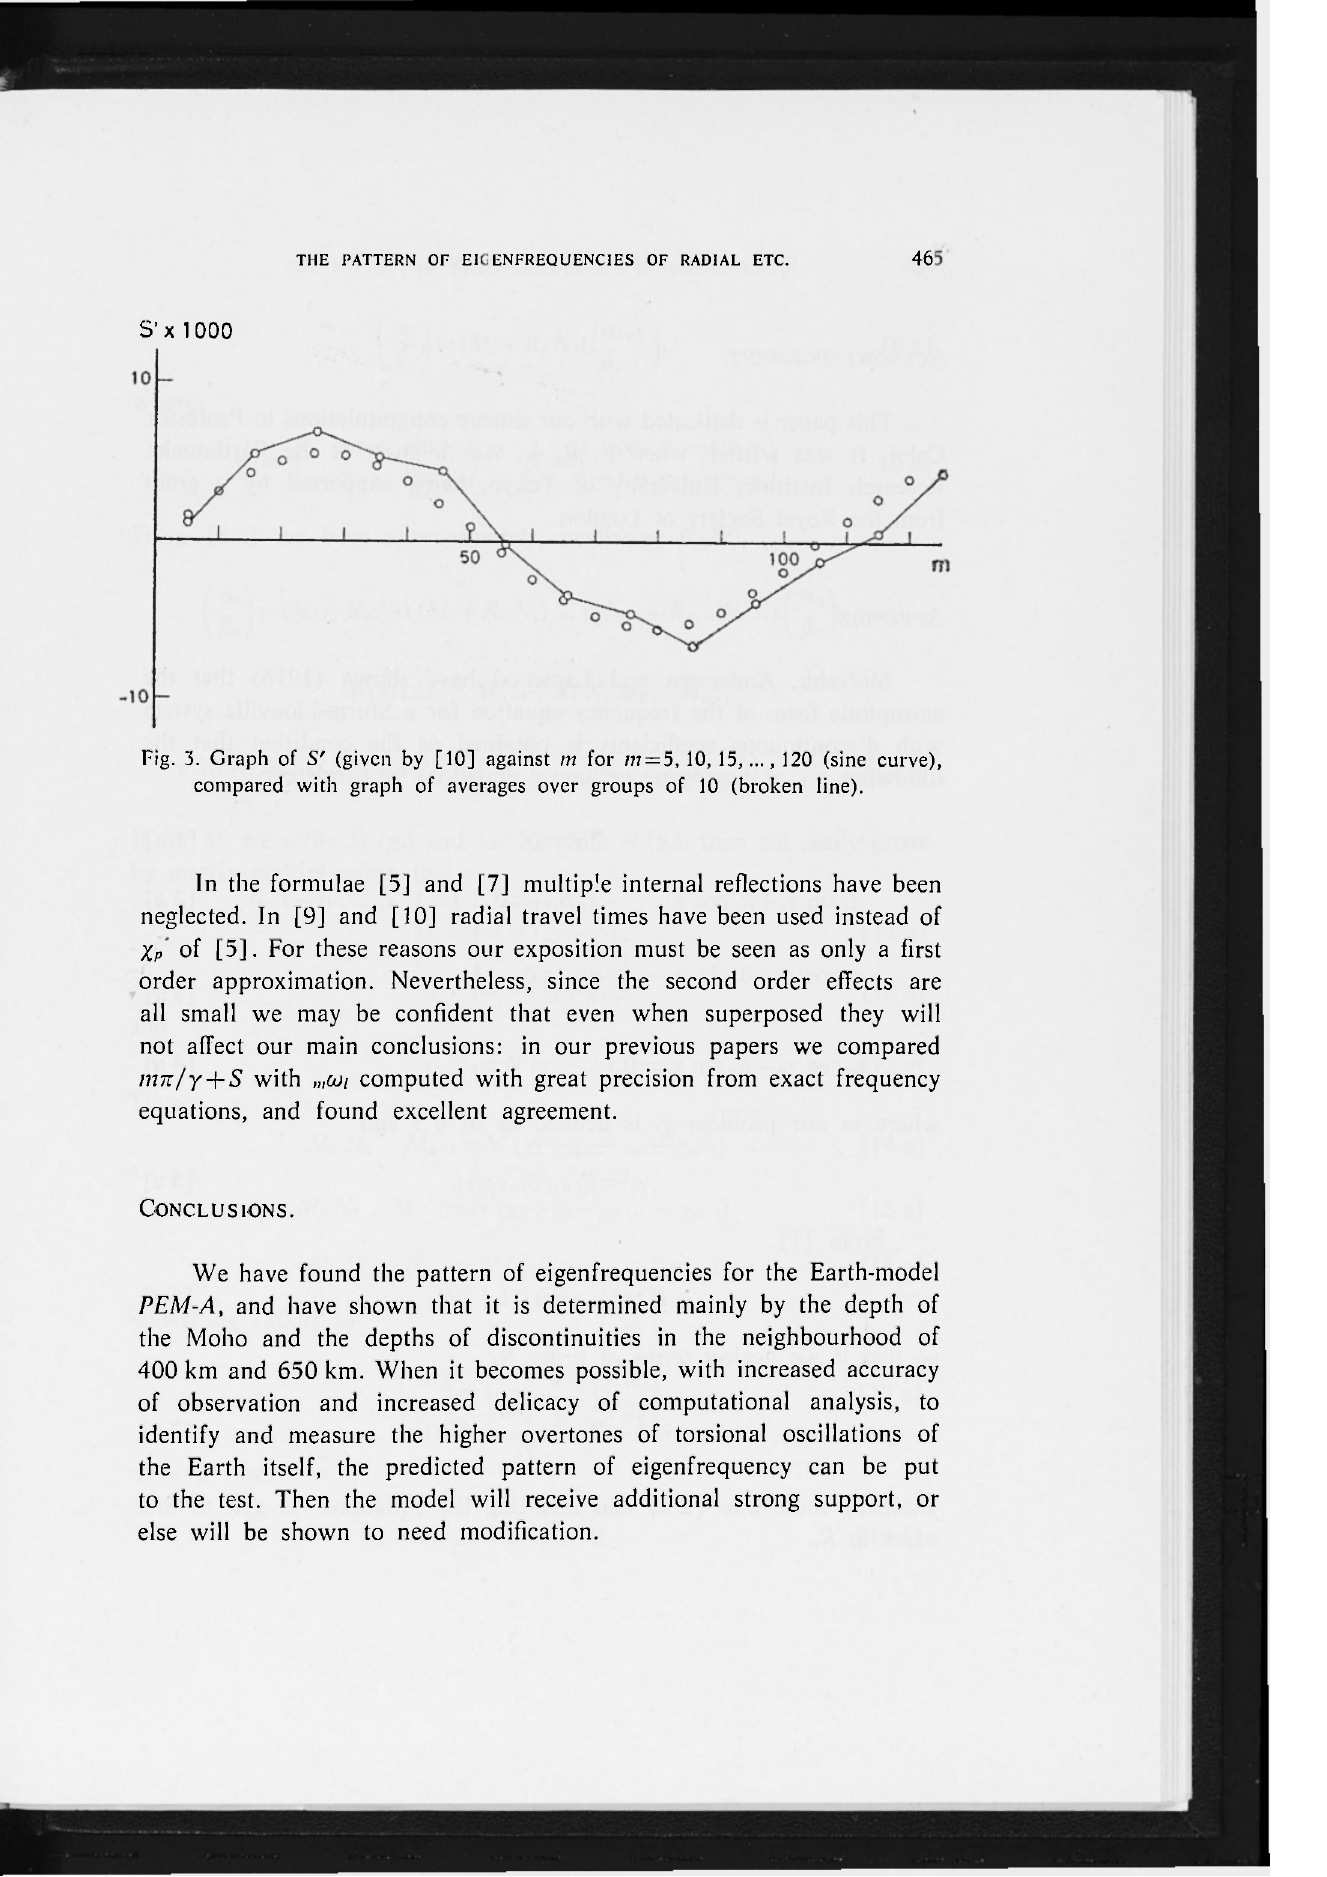
Fig. 3. Graph of S' (given by [10] against m for m = 5, 10, 15,..., 120 (sine curve), compared with graph of averages over groups of 10 (broken